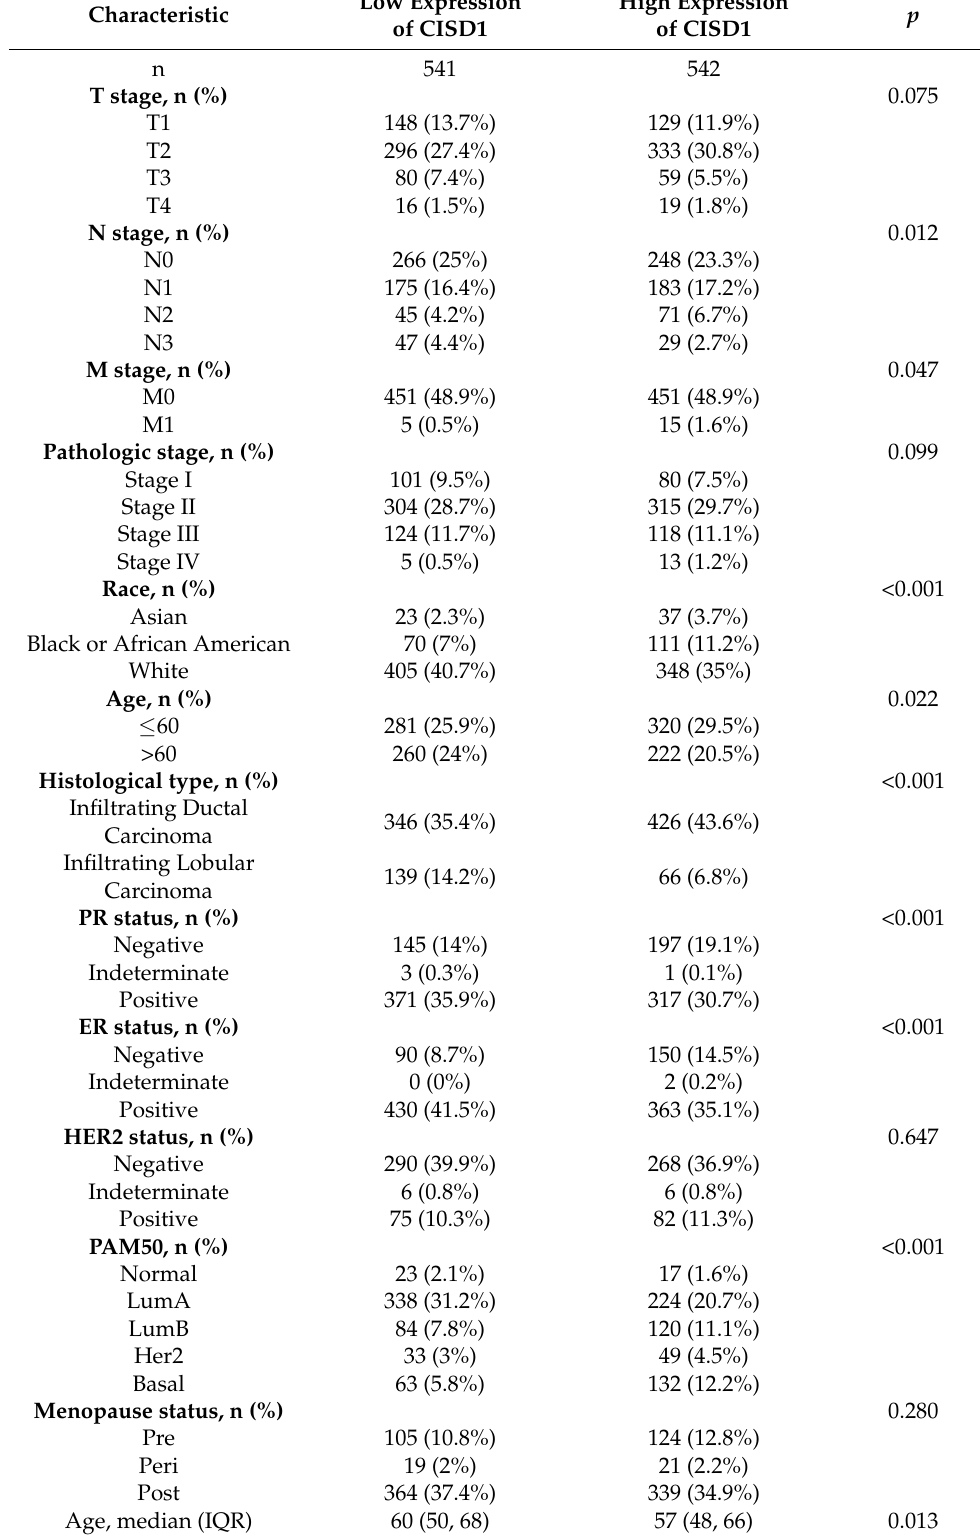
Table 1. Breast cancer clinicopathological characteristics and CISD1